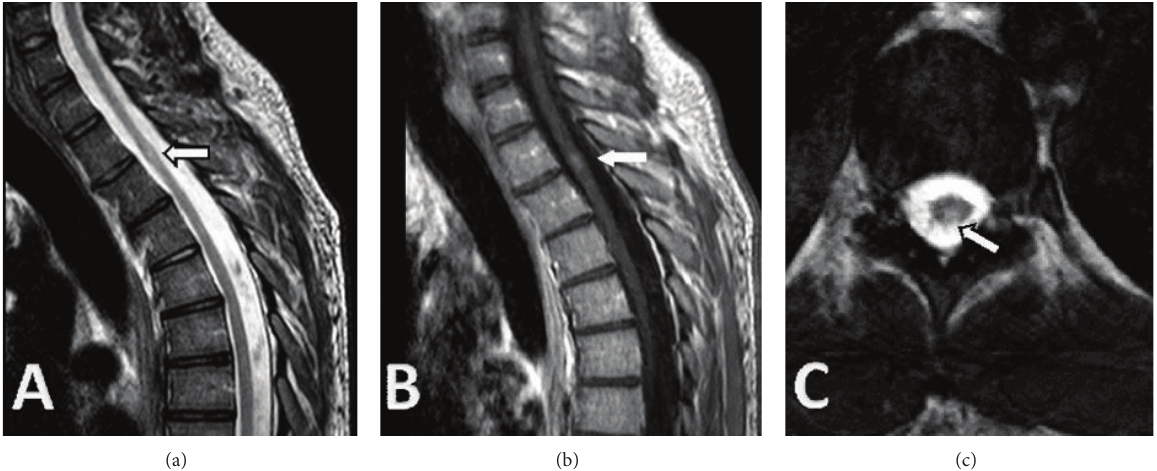
Figure 2: Thoracic spinal cord MRI at second attack. (a) Sagittal T2-weighted image showing a hyperintense lesion at T3 level. (b) Sagittal T1-weighted image showing gadolinium-enhancement of the lesion at T3 level. (c) Axial T2-weighted image showing a hyperintense lesion at T11